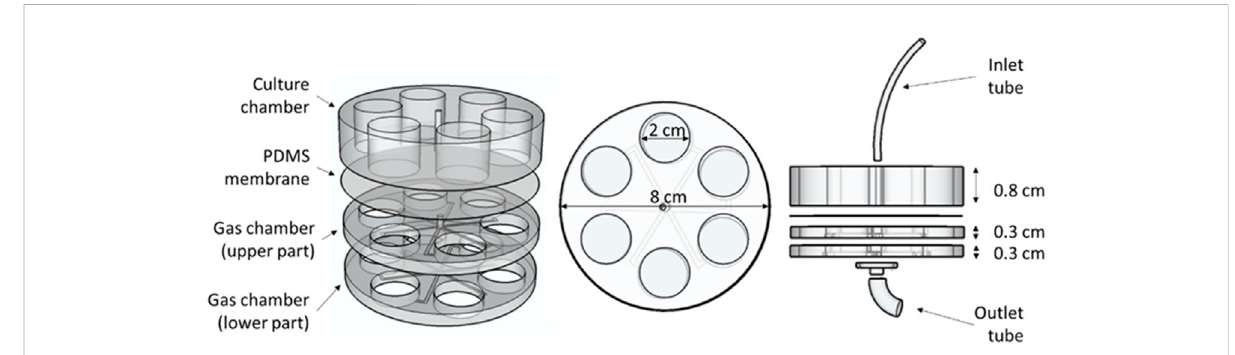
FIGURE 1 Chip design. Dimensions and different parts of the chip can be observed in this 3Drepresentation. The upper part forming the culture chamber and the two lower parts forming the gas chamber can be easily distinguished, separated by the PDMS